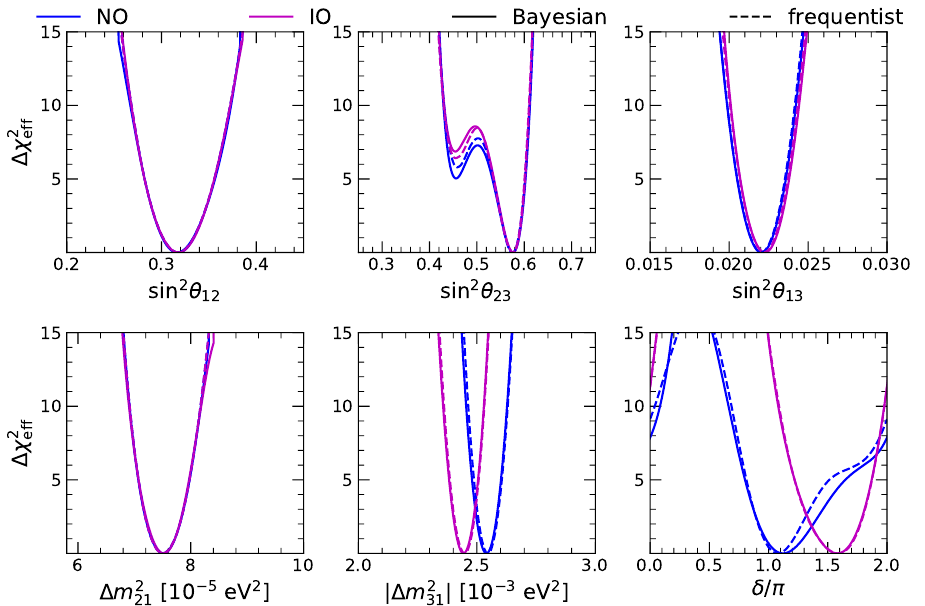
Figure 10 . Summary of neutrino oscillation parameters from our global fit, comparing the Bayesian (solid) and frequentist (dashed) determinations obtained for normal (blue) and inverted (magenta) ordering. Note that inverted ordering results are normalized with respect to the minimum χ 2 of inverted